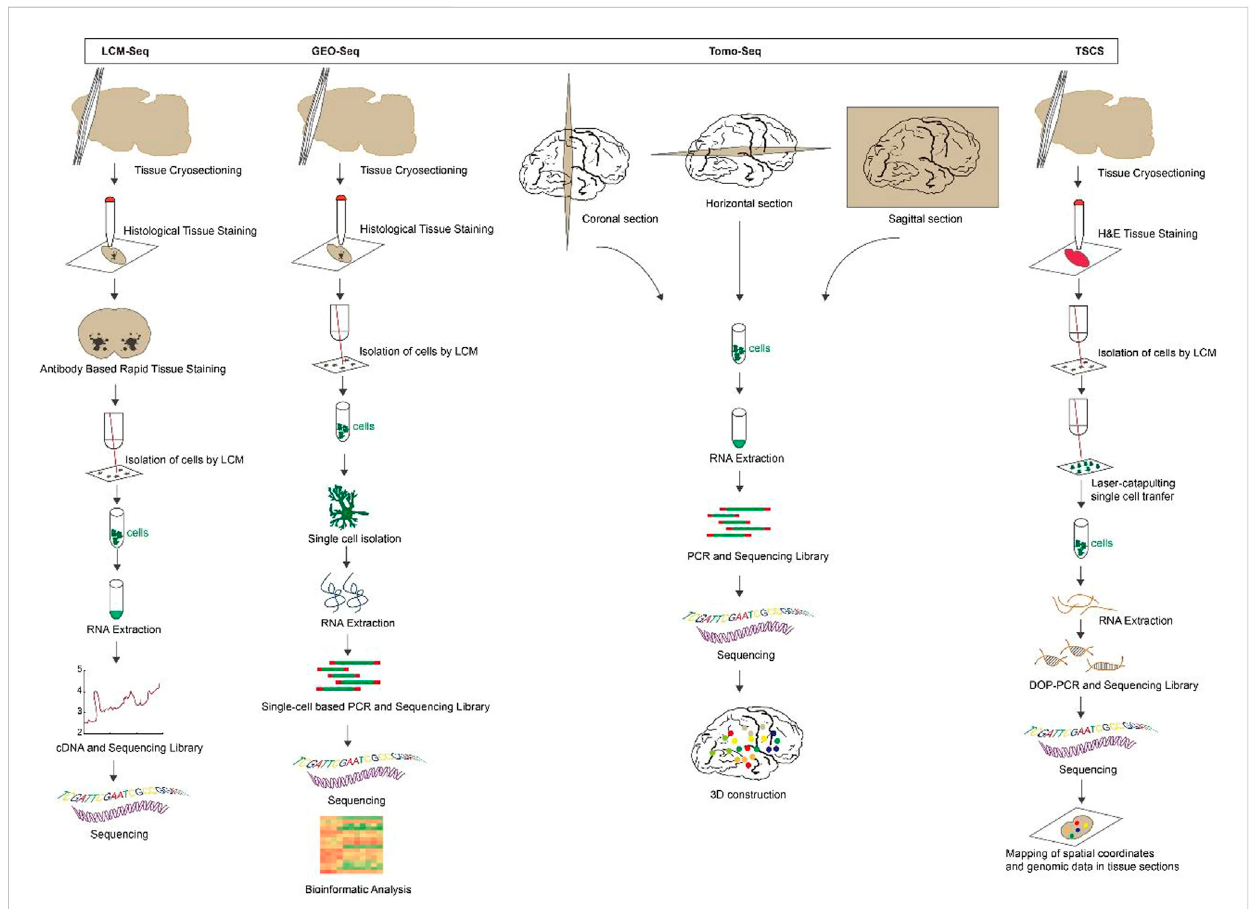
FIGURE 1 The overview and principle of spatial transcriptome technologies based on